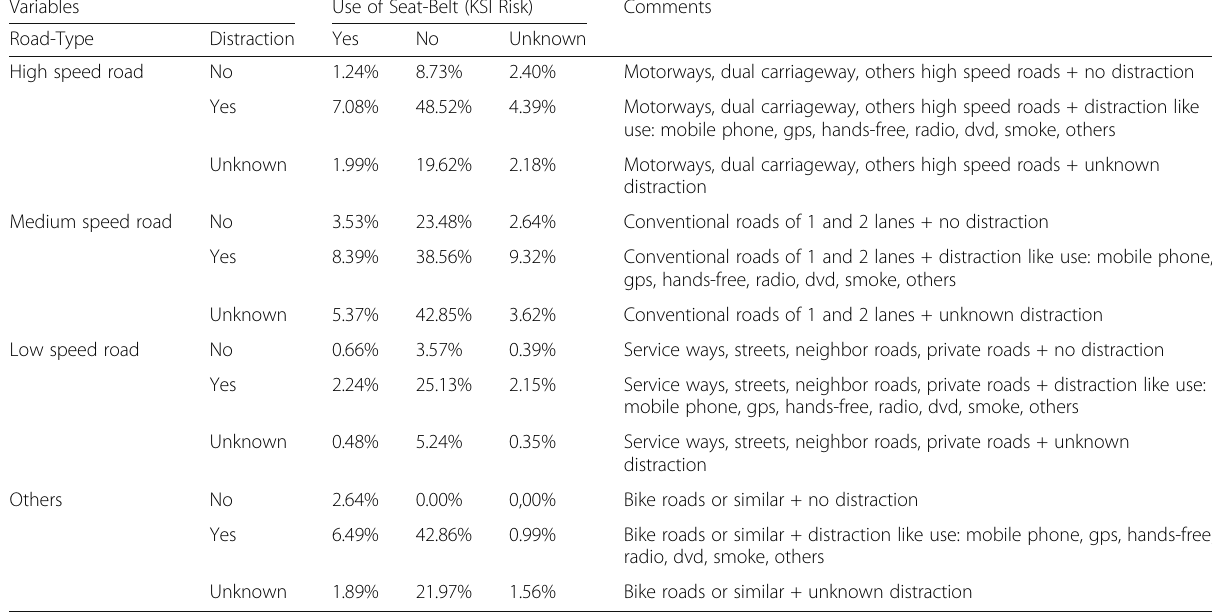
Table 7 Probabilities of suffering a serious accident, depending on the use of seat belt and the most influential variables in driver injury severity. Processed by the